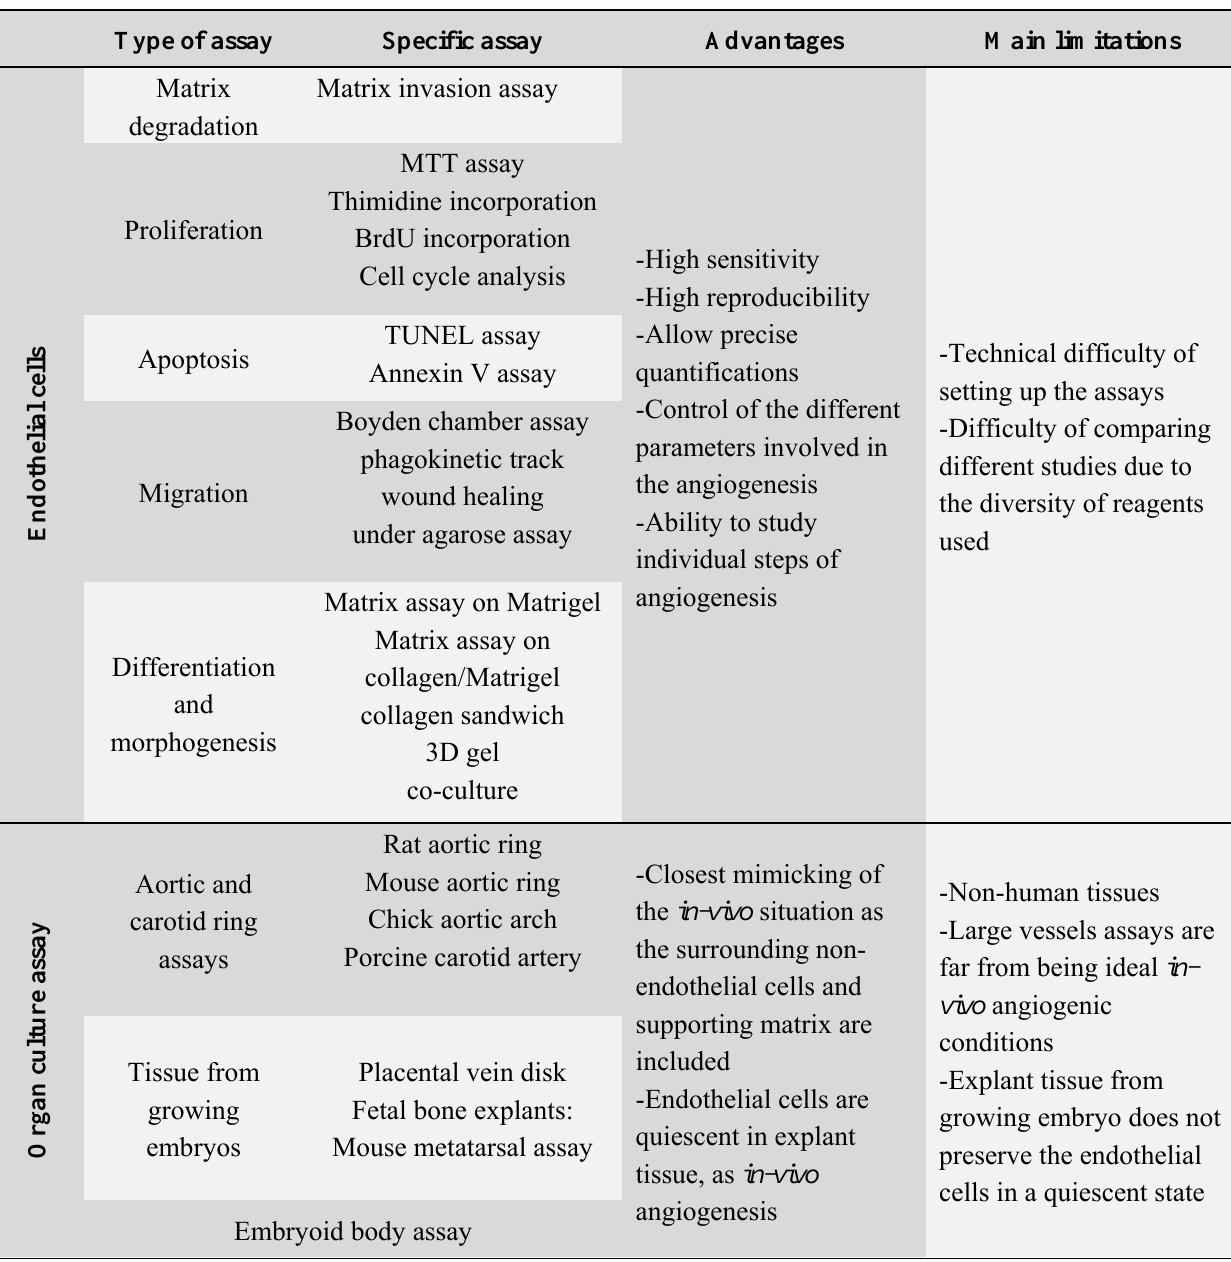
Table 2. Advantages and limitations of the most important in-vitro angiogenesis assays used with endothelial cells and organ